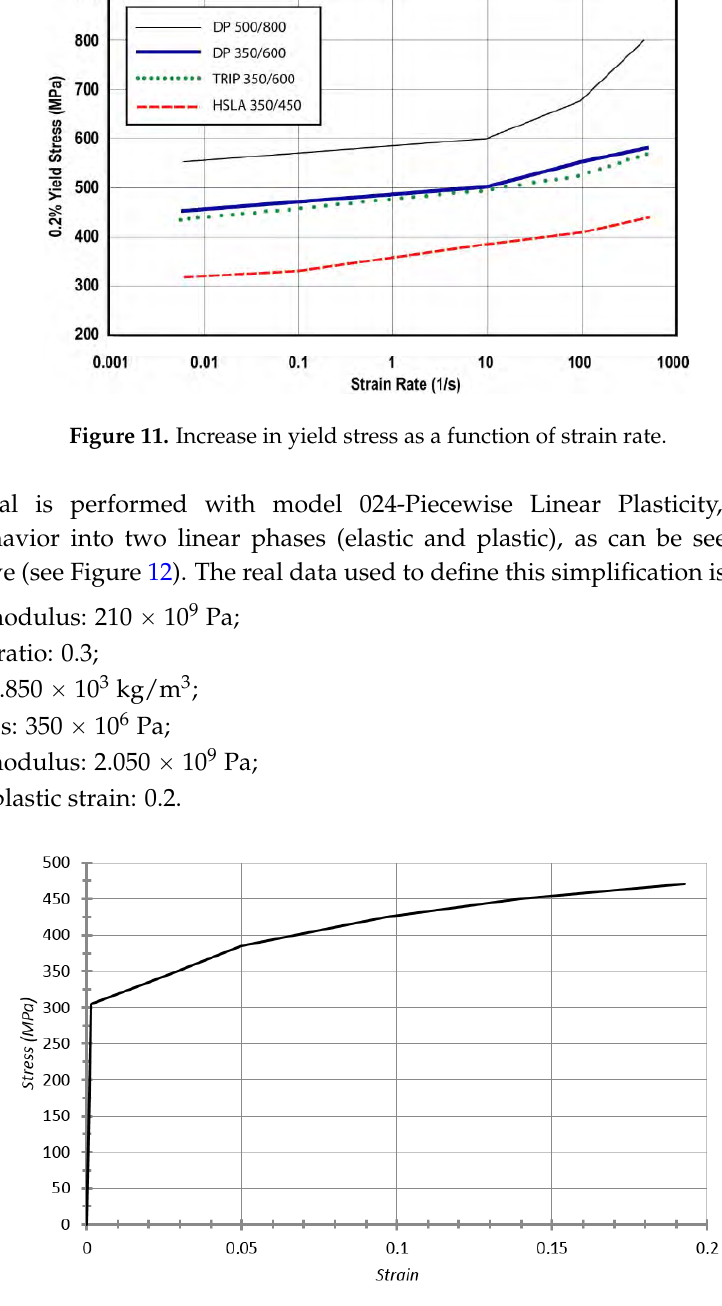
Figure 12. Stress–strain curve for bilinear material TRIP 350 ‐ 600. Table 1. Multiplying factor for yield stress as a function of strain rate. Strain Rate (s − 1 )